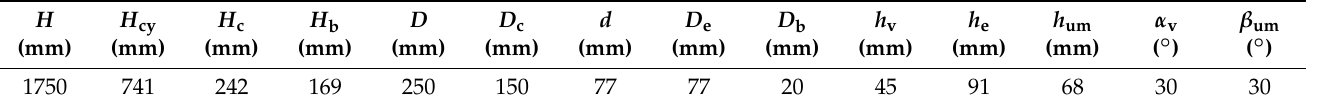
Figure 2. Cyclone separator model. Table 1. Main structural parameters of cyclone